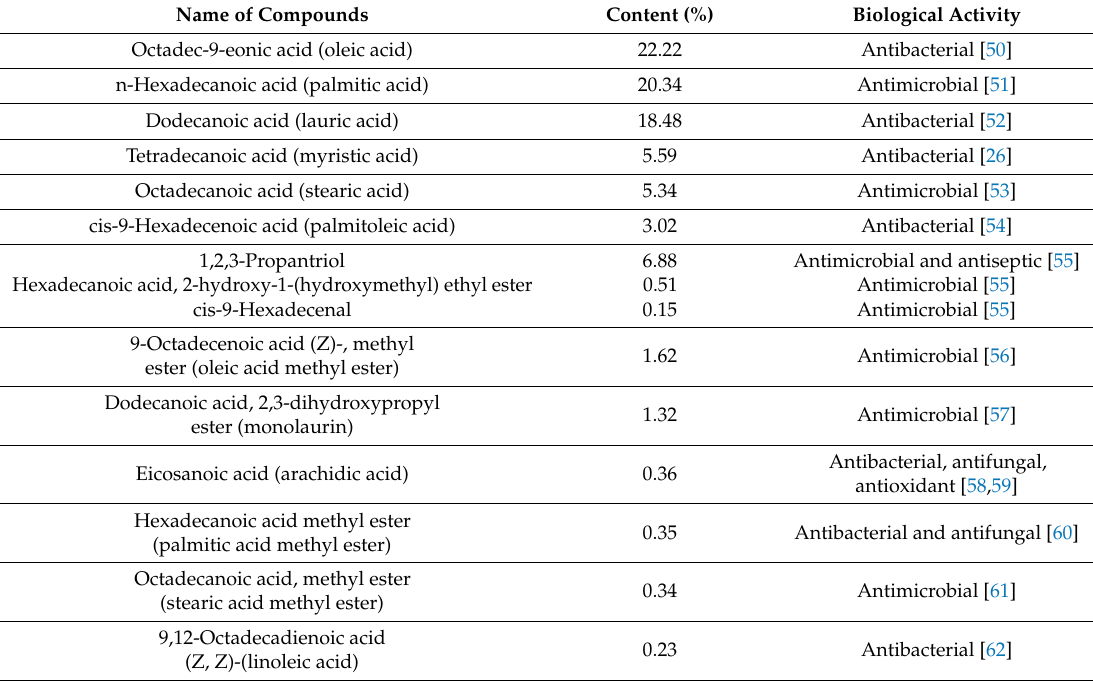
Table 5. The content and published biological activity of major constituents of AWME of H. illucens larvae